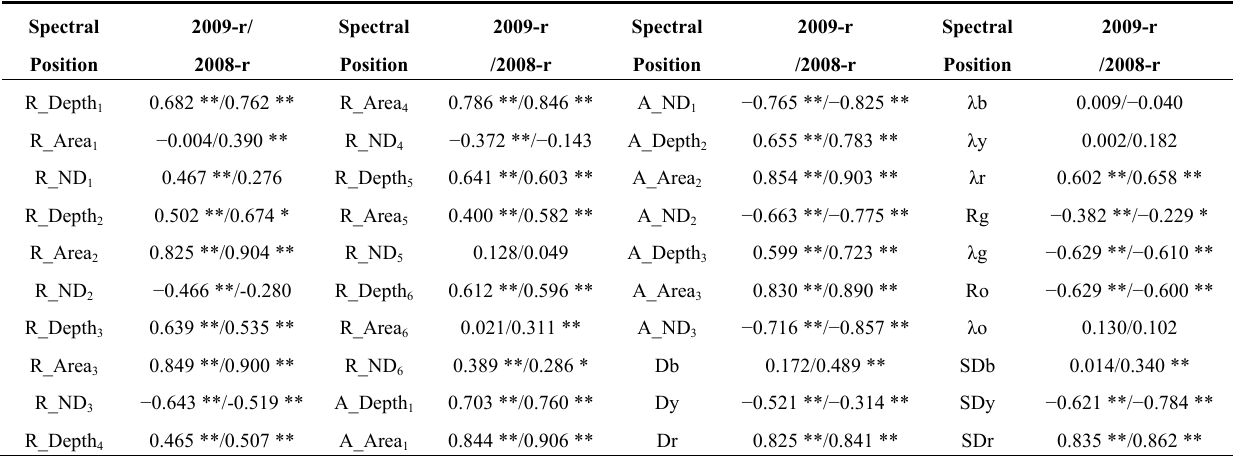
Table 5. Correlations between spectral position features and LAI in different years.